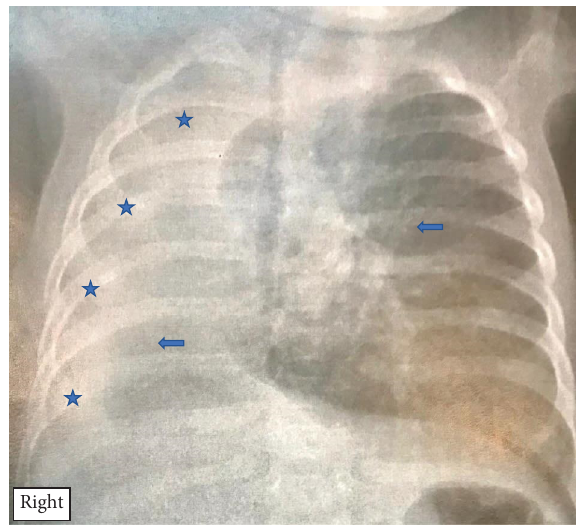
Right Figure 1: Frontal chest radiograph in a 4-month-old infant, showing right thoracic opacity (stars), hypertrophy and mediastinal herniation of the left lung (arrows), and lack of visualization of the left stem